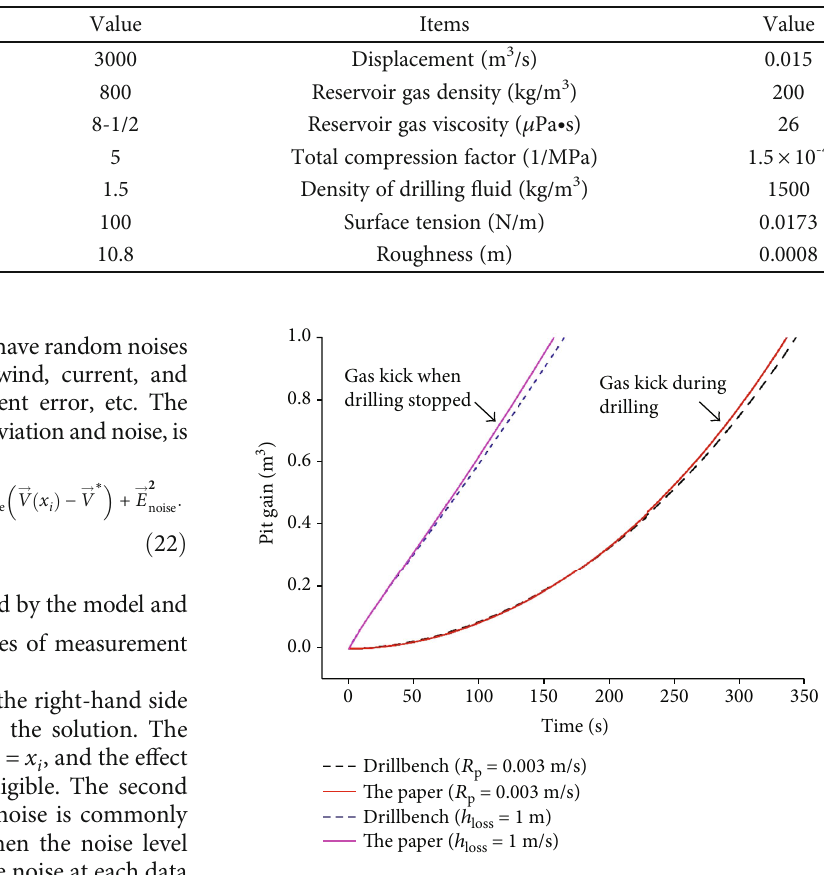
Figure 2: Comparison of pit gain variations calculated via di ff erent models under drilling and cessation conditions.